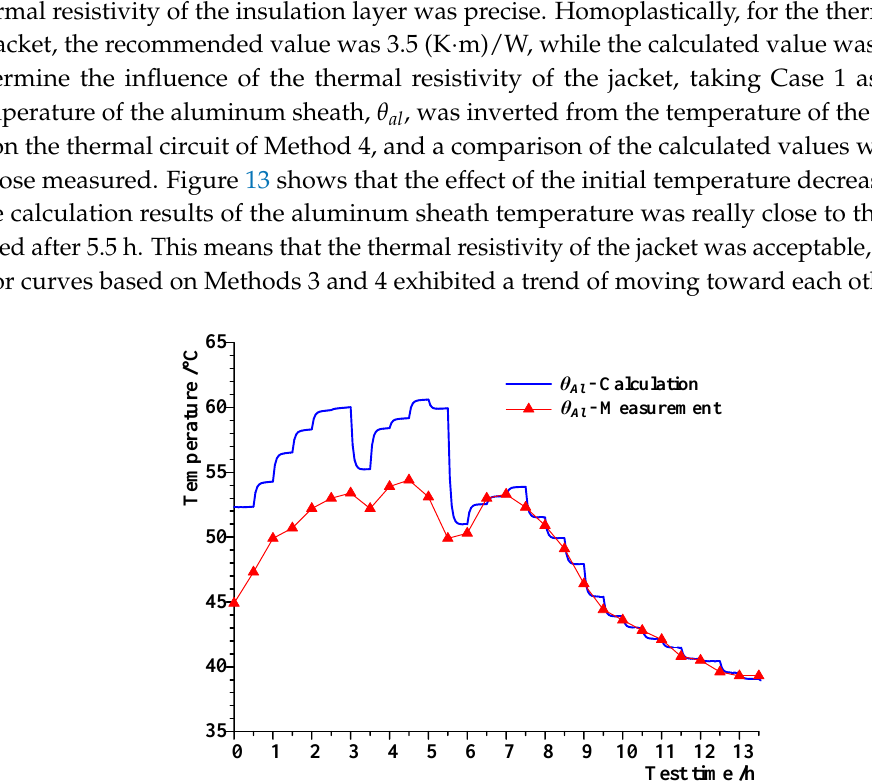
Figure 13. Aluminum-sheath temperature calculation results (Case 1).